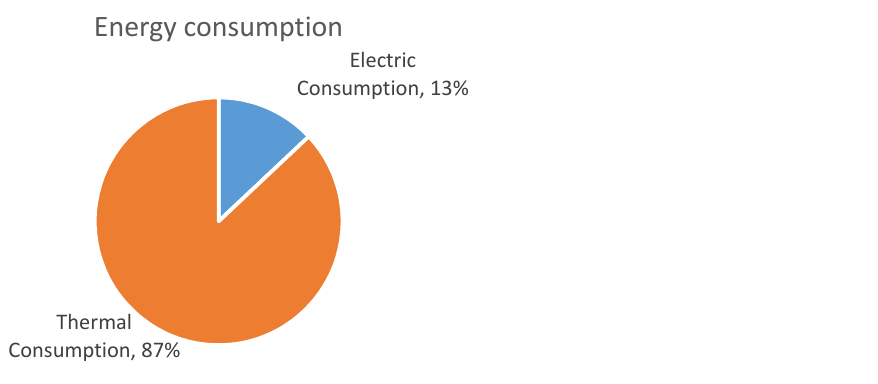
Figure 11. NACE 23.51 EA analysis: global consumption distribution between electricity and heat.